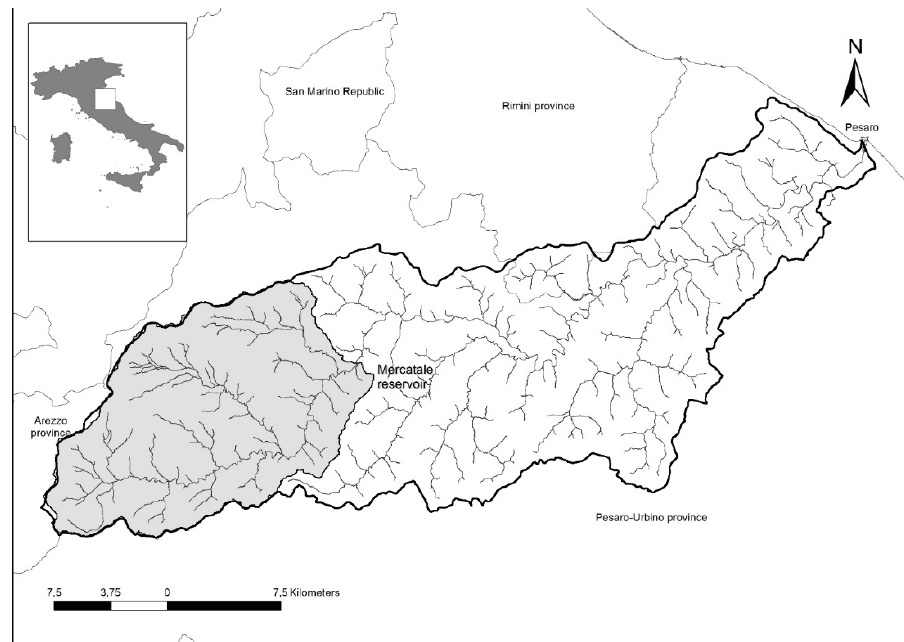
Figure 1. The study area of the upper Foglia river basin.